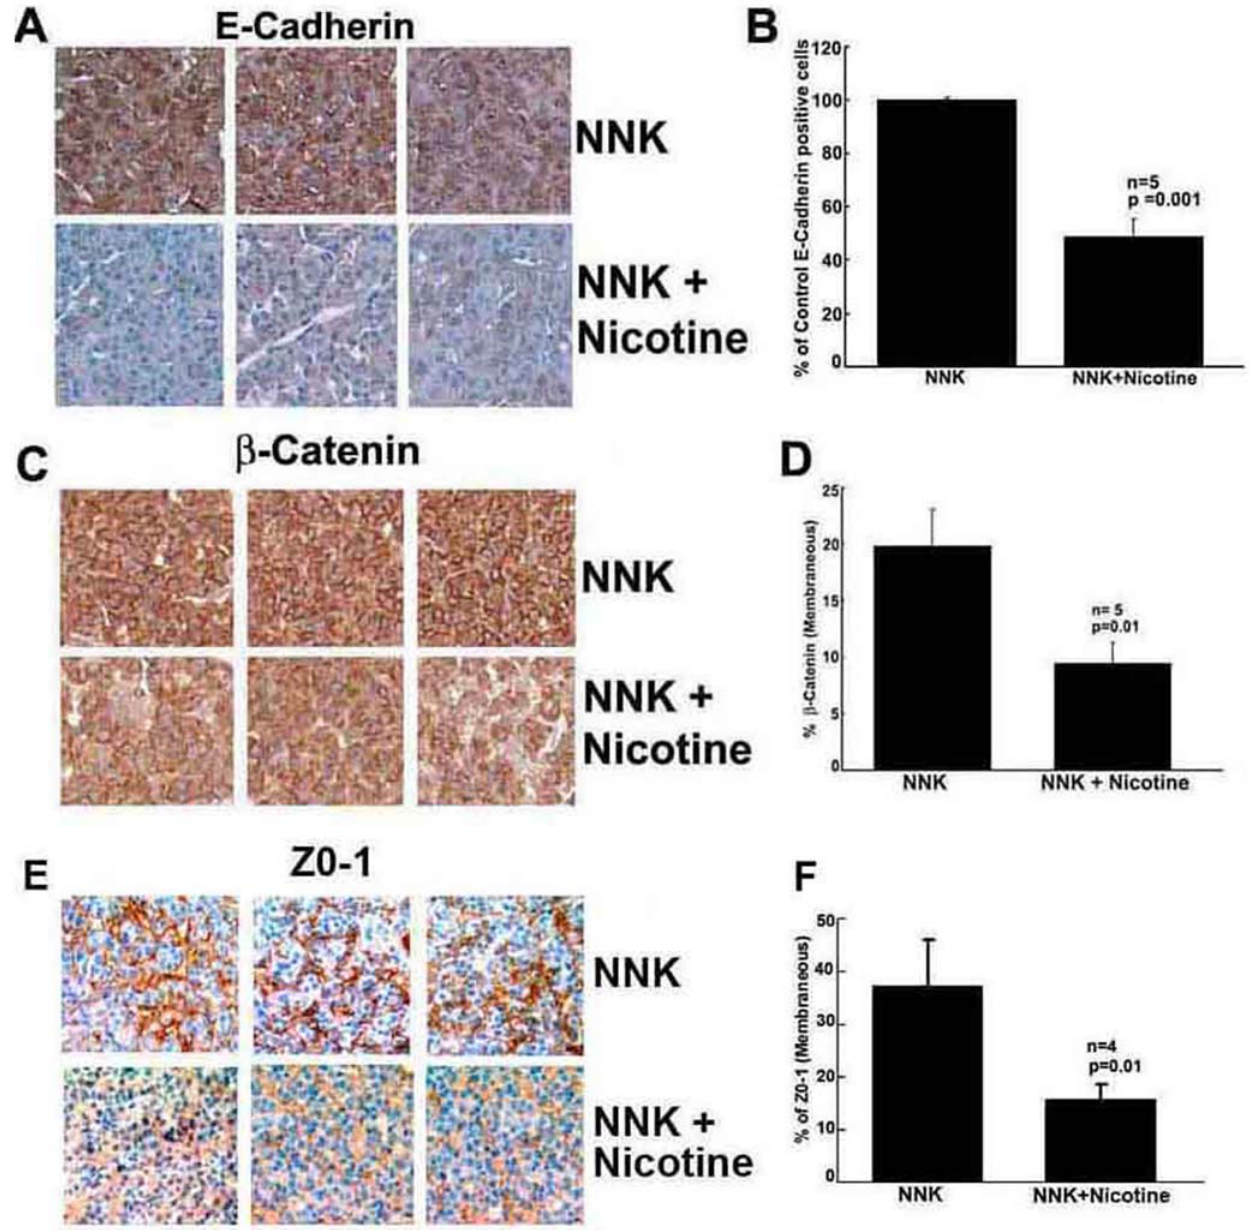
Figure 5. Nicotine reduced the expression of epithelial markers in A/J mice. (A) E-Cadherin staining of A/J lung tumors induced by NNK or NNK + nicotine. (B) Quantitation of E-Cadherin intensity in tumors (C) b -Catenin staining of A/J lung tumors induced by NNK or NNK + nicotine. (D) Quantitation of membranous b -Catenin. (E) ZO-1 staining of A/J lung tumors induced by NNK or NNK + nicotine. (F) Quantitation of membranous ZO-1.